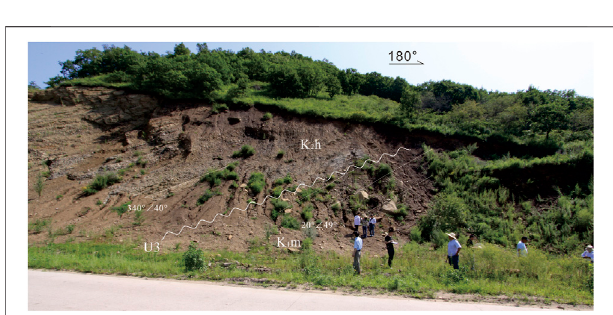
FIGURE 6 | Angular unconformity between the Houshigou and Muleng Fms (U3) (see Figure 4 for the locations).